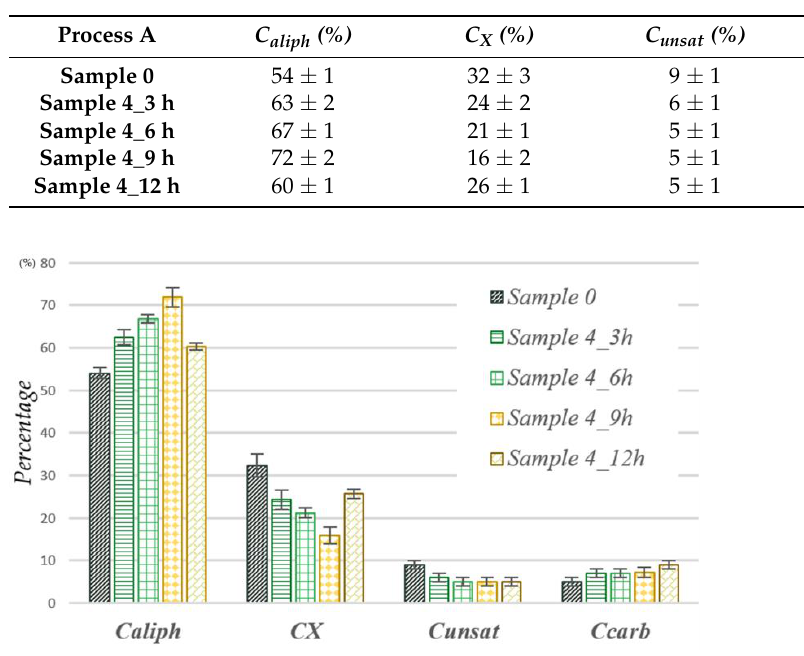
Figure 4. Relative distribution, expressed as percentage (%), of the carbon groups C aliph , C X , C unsat , and C carb for process A samples and comparison with Sample 0.